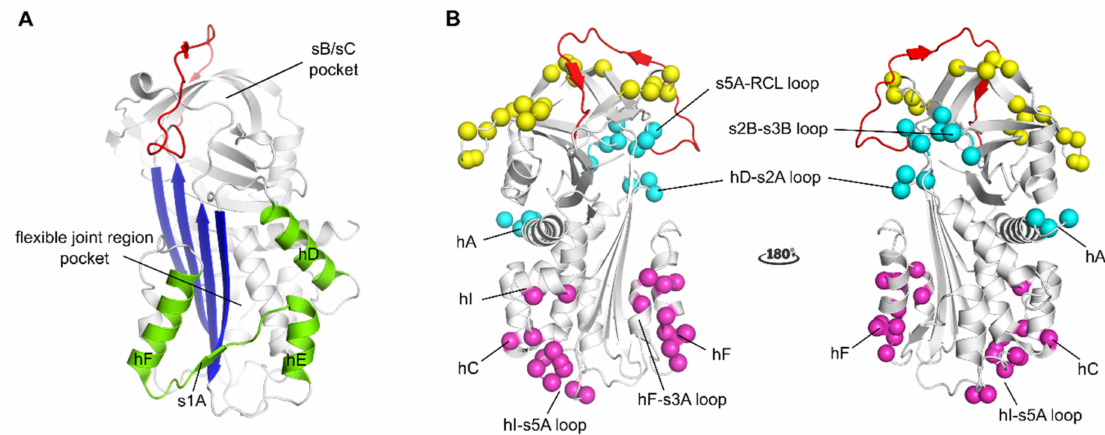
Figure 2. Localization of binding regions for PAI-1 inhibitors in the structure of active PAI-1. ( A ) Localization of the binding regions for small molecule PAI-1 inhibitors. The binding pocket in the flexible joint region is aligned by hD, hE, hF and strand 1 (shown in green). The sB/sC pocket is aligned by β -sheet B and C ( B ), localization of different epitopes of antibodies and antibody fragments as determined by mutagenesis and X-ray crystallographic studies. The epitopes of Abs that prevent the interaction between PAI-1 and PAs comprise residues that are indicated by yellow spheres (exosites for PAs on PAI-1) and residues in the reactive center loop (RCL) (shown in red). The epitopes of switching Abs are indicated by magenta spheres and comprise either residues located in hF and the loop connecting hF and s3A or residues located in the loop connecting hI and s5A, hC and hI. The epitopes of latency-inducing Abs are indicated by cyan spheres and comprise in hA or residues at the top part of the PAI-1 molecule in the hD-s2A loop, the s2B-s3B loop, and the s5A-RCL loop. All panels have been generated using the structure of active PAI-1 (PDB ID